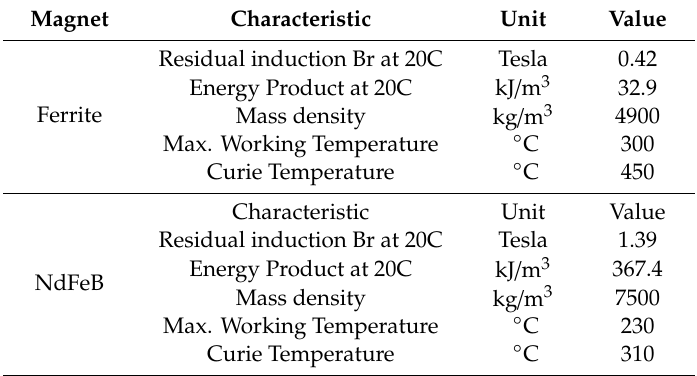
Table A1. Permanent magnet characteristics [22].